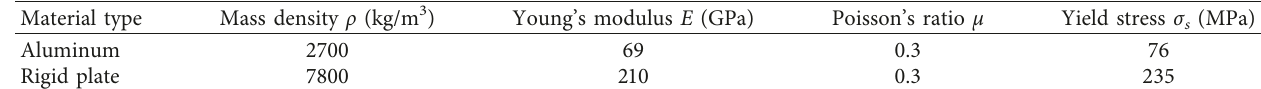
Figure 2: Finite element models of three honeycombs under in-plane impact. Table 1: Attributes of honeycomb and rigid